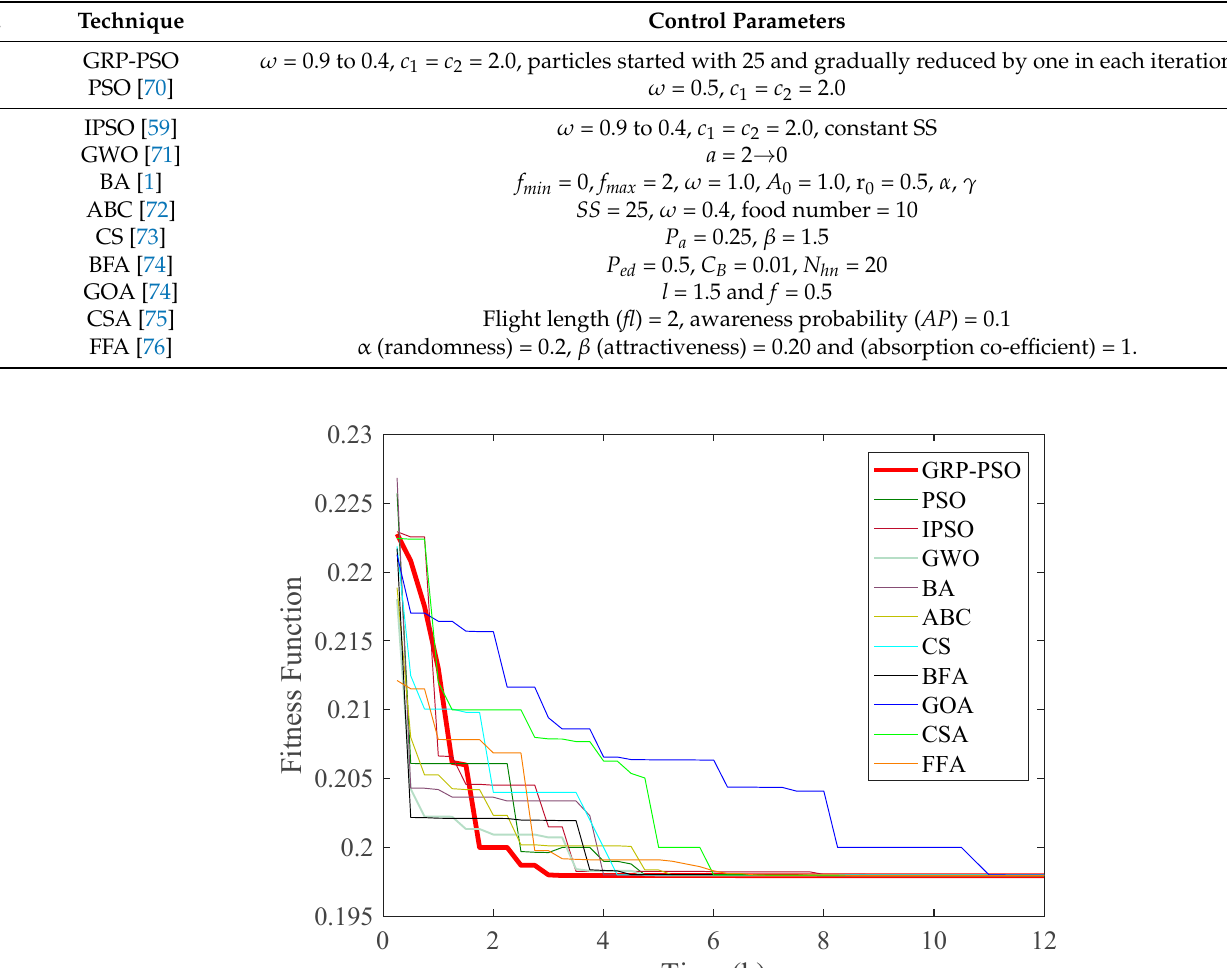
Table 3. The control parameters of the benchmark optimization algorithms used in this study.